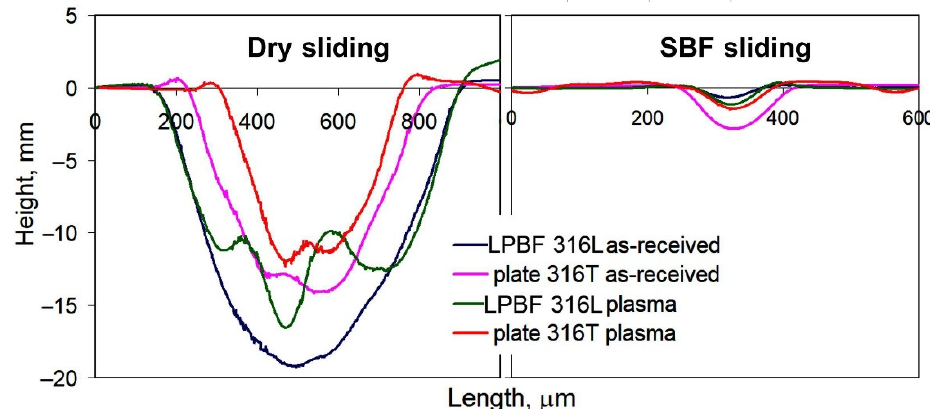
Figure 15. Profiles of wear tracks.